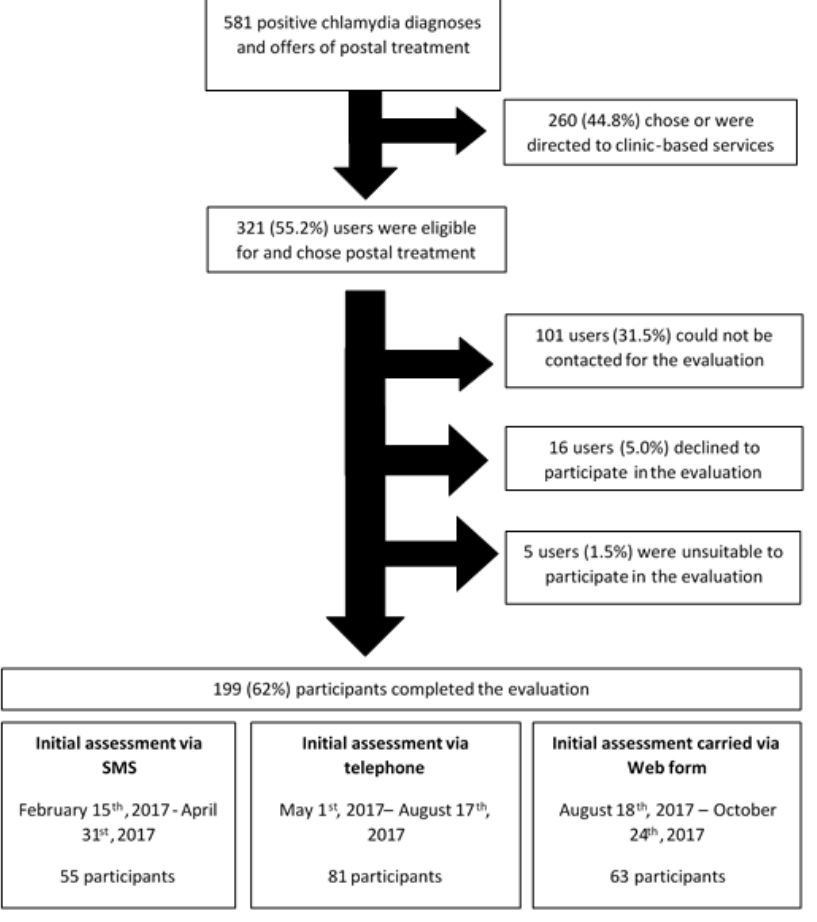
Figure 2. Evaluation